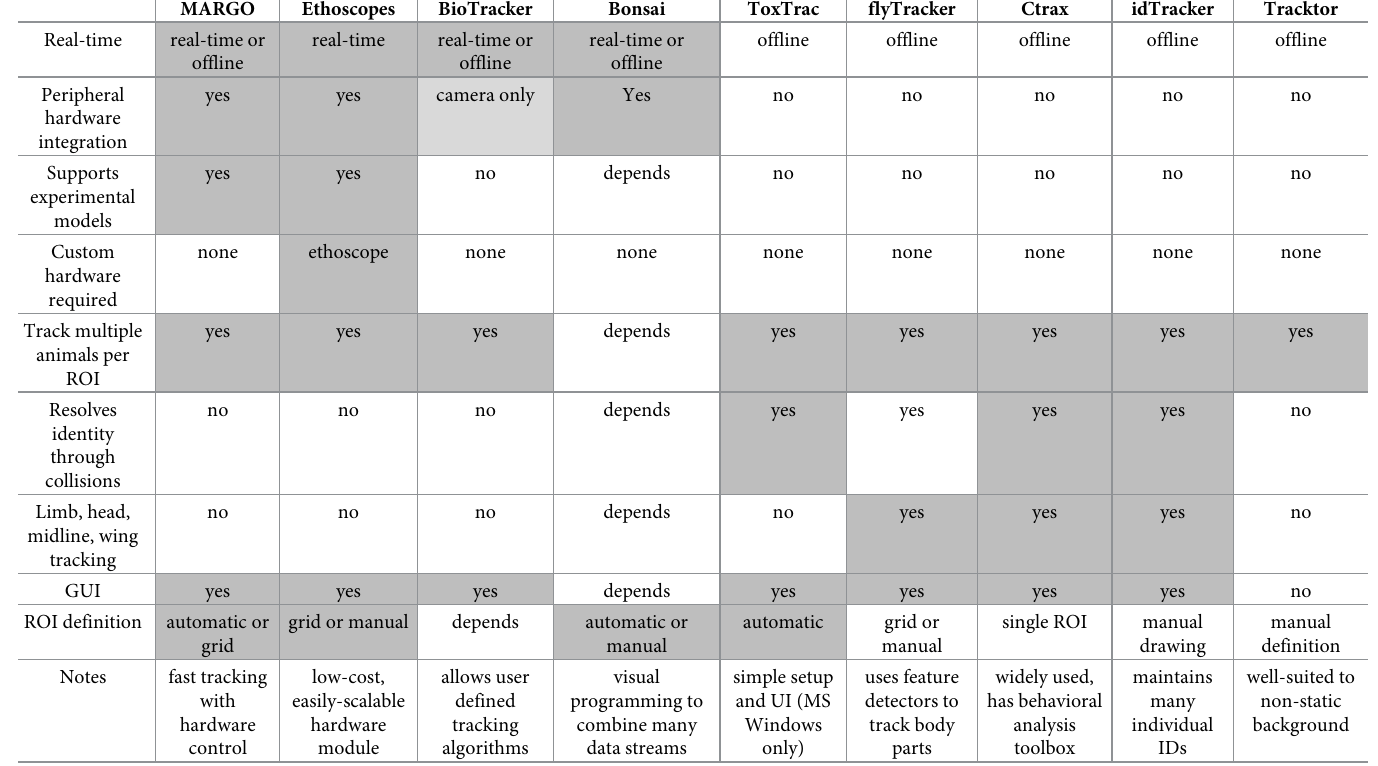
Table 1. Comparison of open-source animal tracking packages. Trackers as falling into two rough categories: 1) real-time trackers capable of very high throughput and potential hardware integration, and 2) offline trackers capable of tracking body parts and/or maintaining individual identities without spatial